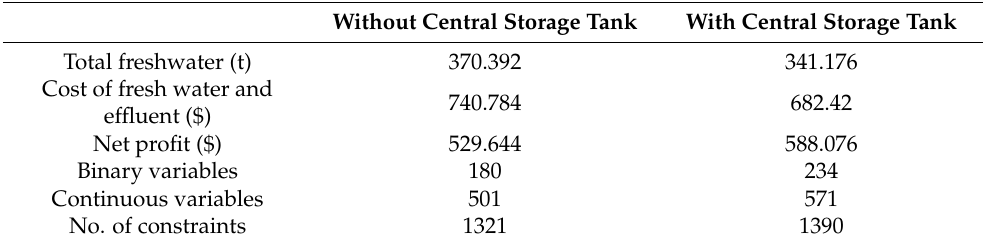
Table 1. Results obtained for the sequential approach for case study